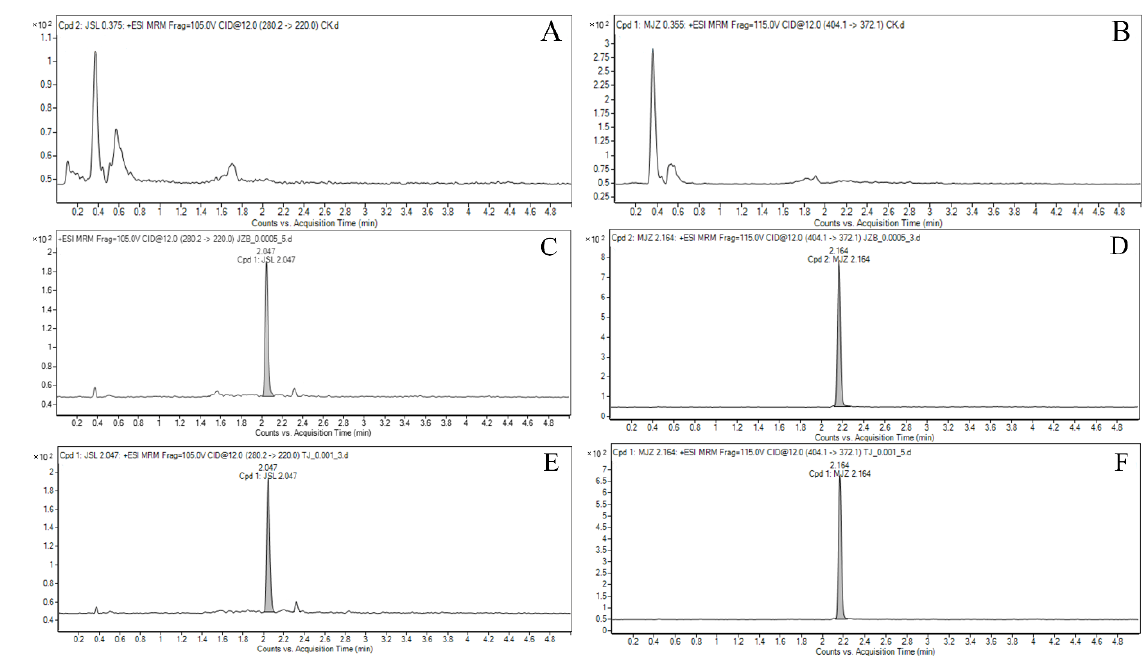
Figure 1. Typical LC-MS/MS chromatograms of metalaxyl-M and azoxystrobin in scallion samples: ( A , B ) blank sample, ( C , D ) matrix standard at 0.0005 mg/L, and ( E , F ) spiked sample at 0.001 mg/kg.